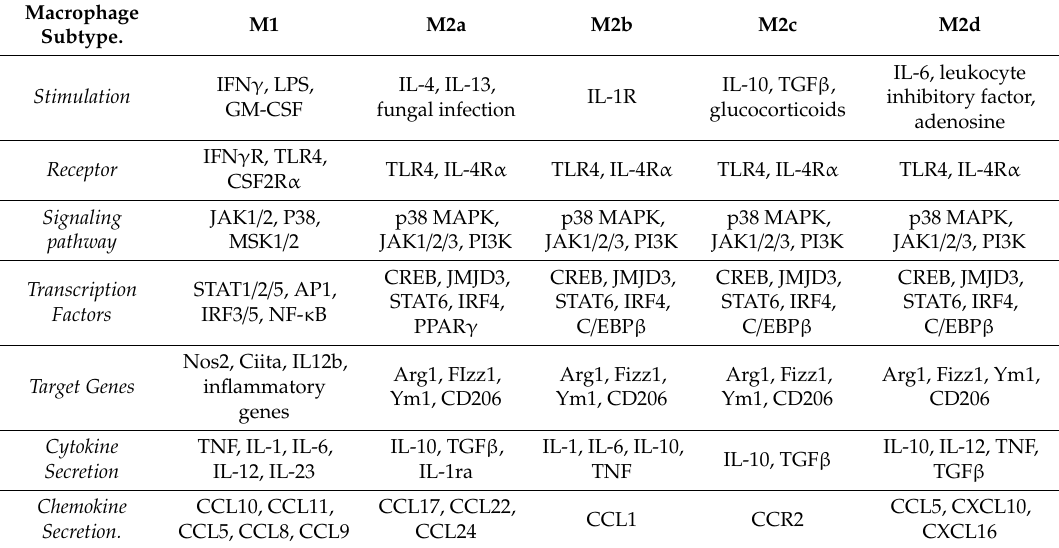
Table 1. Characteristics of M1 and M2